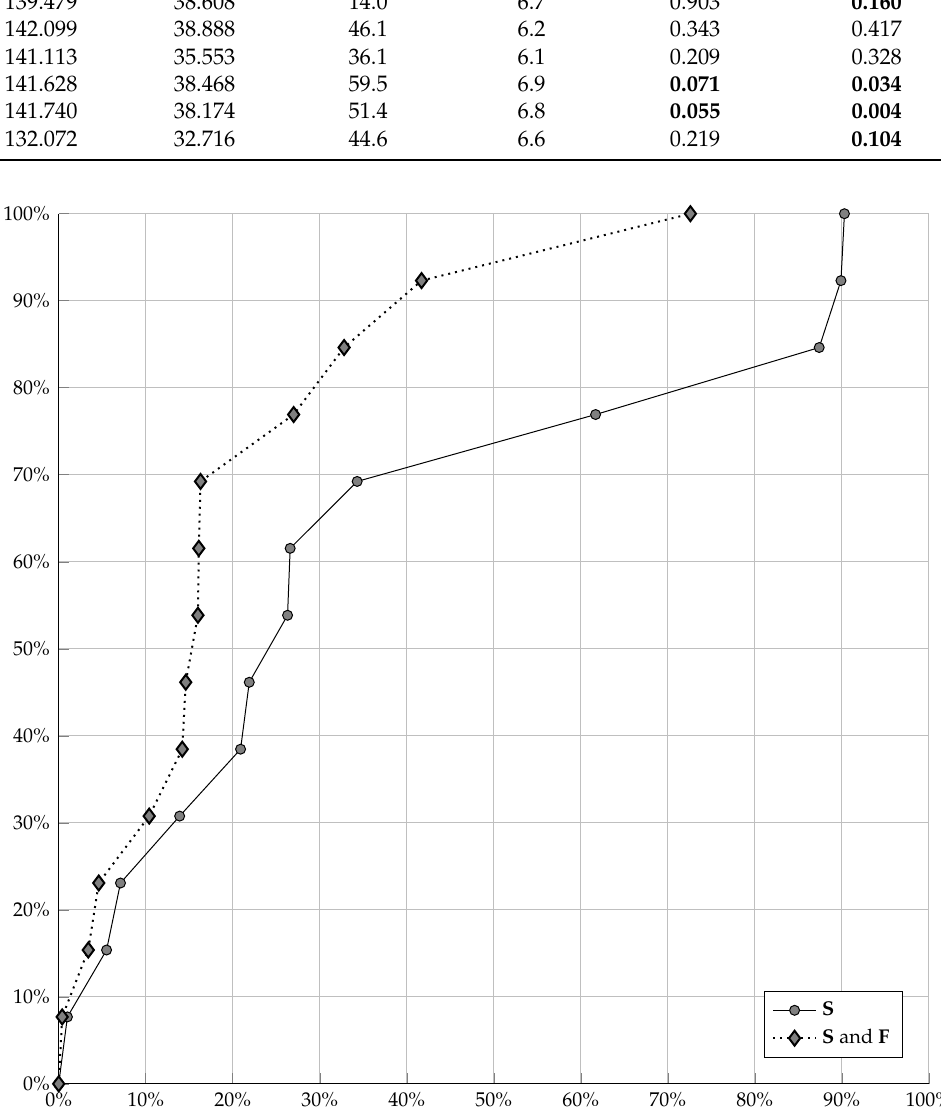
Figure 12. Plots of dependencies U ( V ) in the forecast for Japan region from fields S (density of the earthquake epicenters with Gaussian Kernel smoothing) singly, and both S and F (divergence increasing